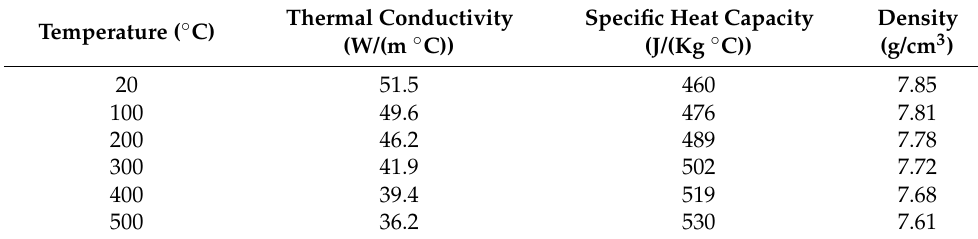
Table 1. Thermophysical property